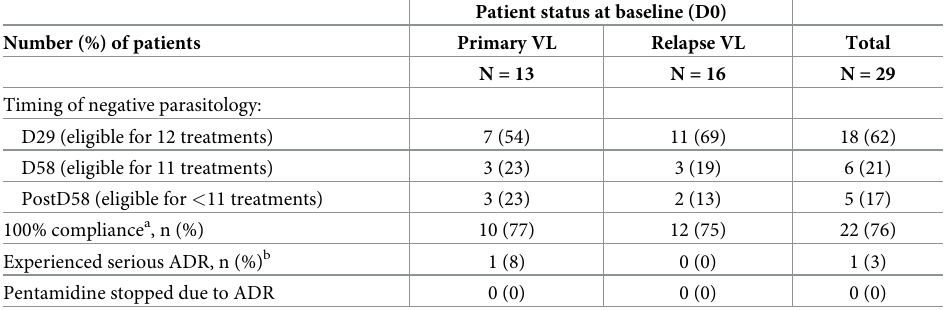
Table 2. Summary table of pentamidine initiation, compliance and safety based on patient type for patients who started